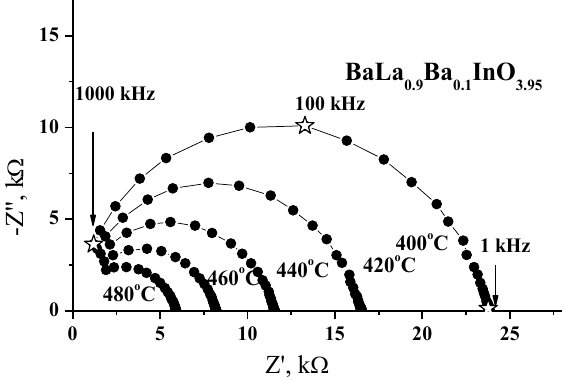
Figure 4. Evolution of the impedance spectra with temperature for the sample BaLa 0.9 Ba 0.1 InO 3.95 in dry air ( p H 2 O = 3.5 × 10 −5 atm).